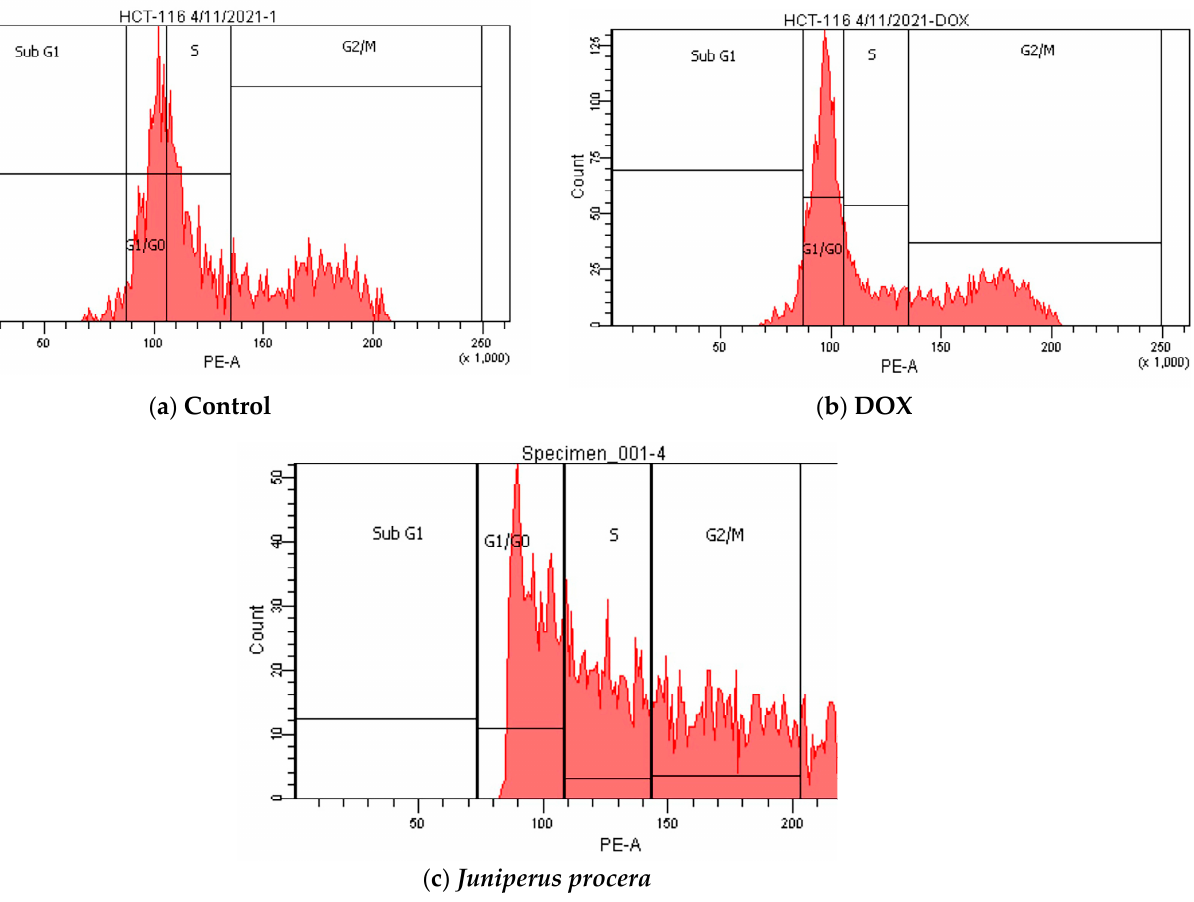
Figure 6. Cell-cycle arrest of untreated HCT 116 ( a ), DOX ( b ), and J. procera methanolic extract ( c ).